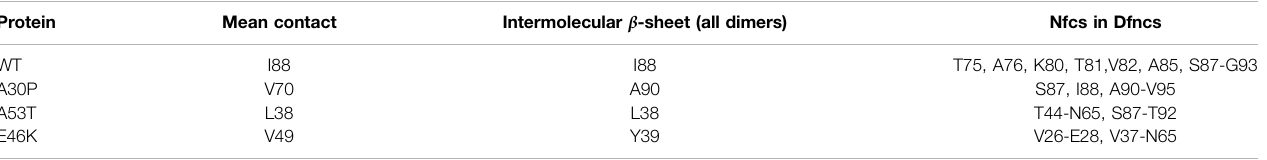
TABLE 4 | Main residues or segments identi fi ed by MD as important for the dimerization of α -syn from the maxima of propensity for the mean contact, intermolecular β - sheets, and Nfcs.